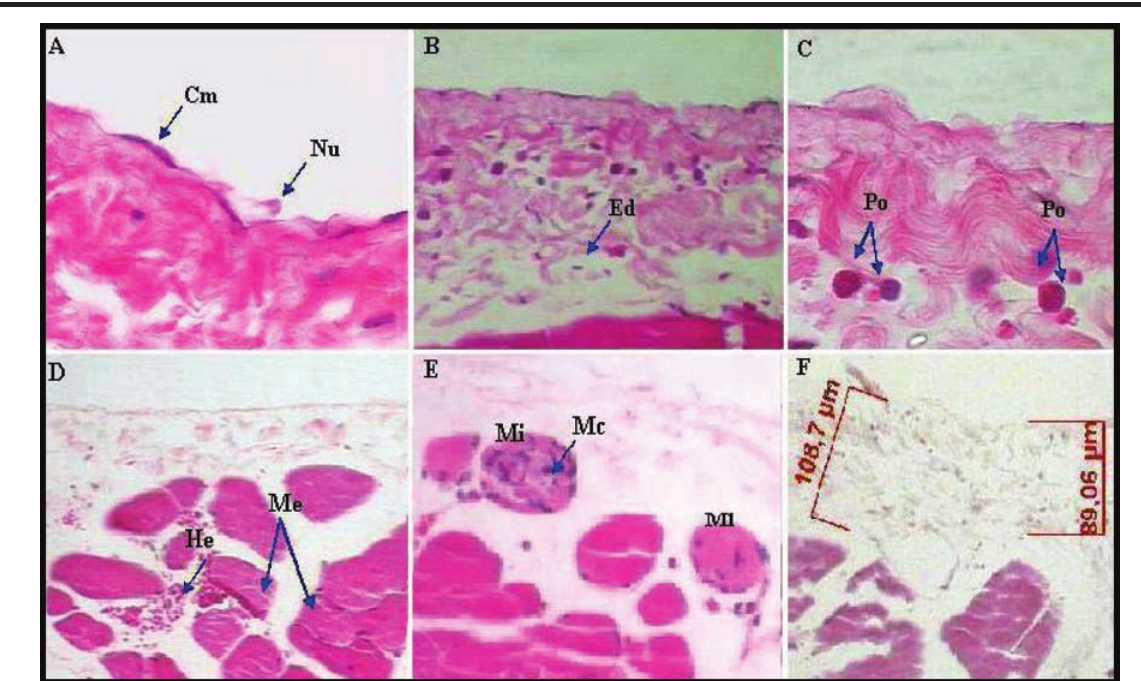
FIGURE 2 - Photomicrography in LM: Preserved mesothelium, 100x (A), edema 40x (B), absence of mesothelium, 100x (C), erythrocyte extravasation, 20x (D), necrosis, ml 40x (E), and increase on the peritoneum thickness, 20x (F) (HE stain). Cm: mesothelial cell, Nu: nucleus, Ed: edema, Po: polymorphonuclear, He: erythrocytes, Mi: myocytes, Mc: macrophages; Me: skeletal